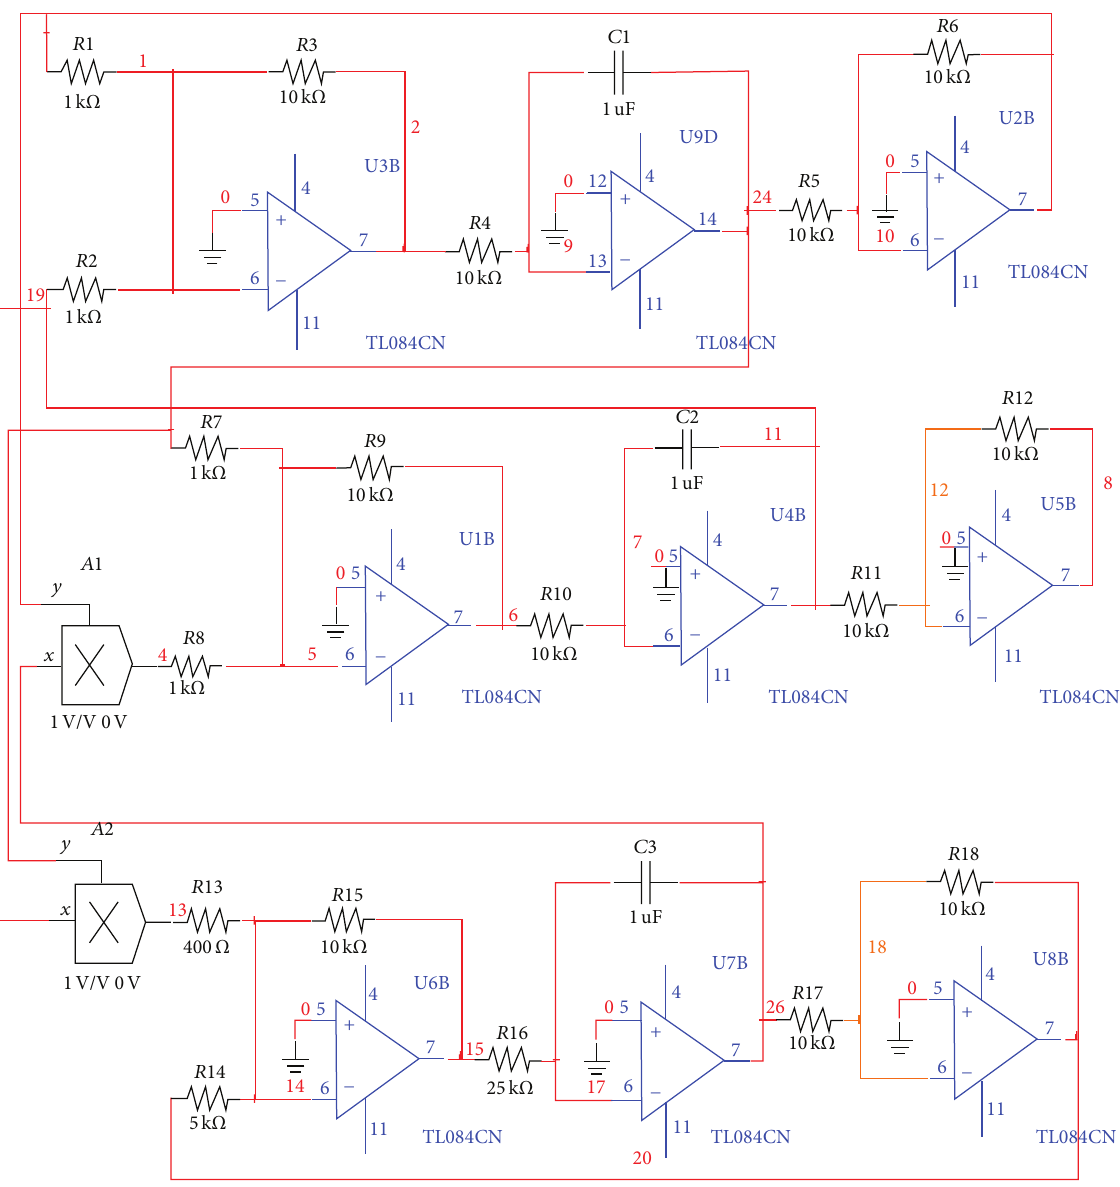
Figure 14: Circuit diagram for realizing the chaotic attractor of